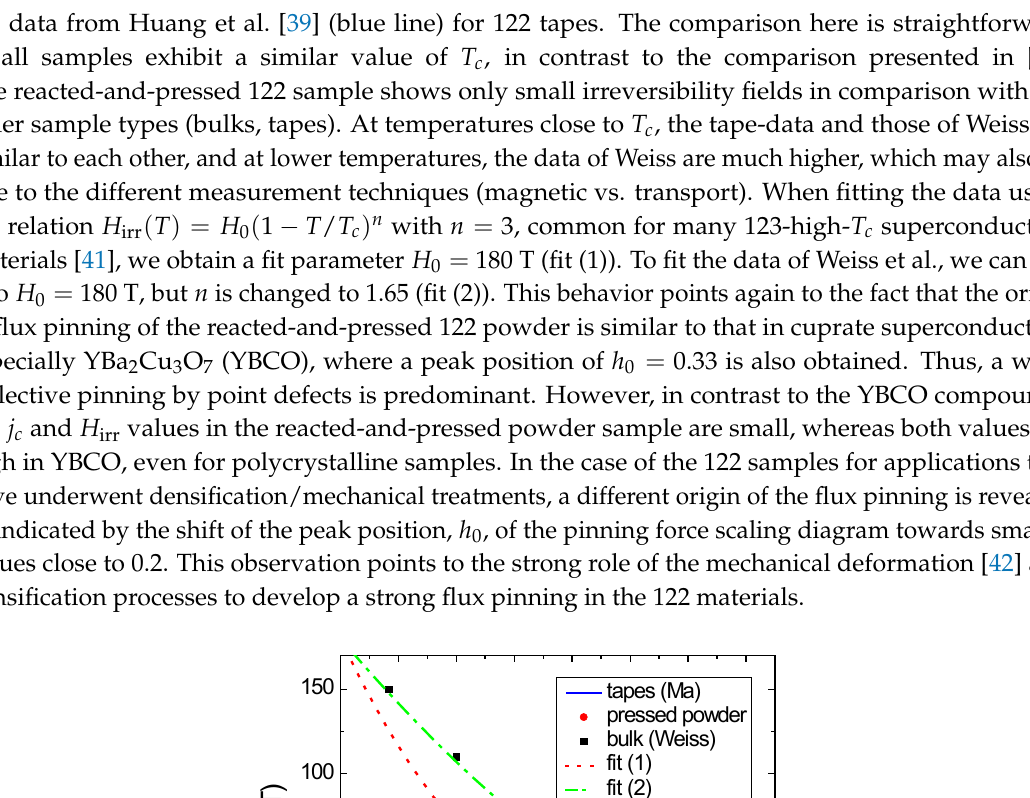
), tapes indicated (cid:32)